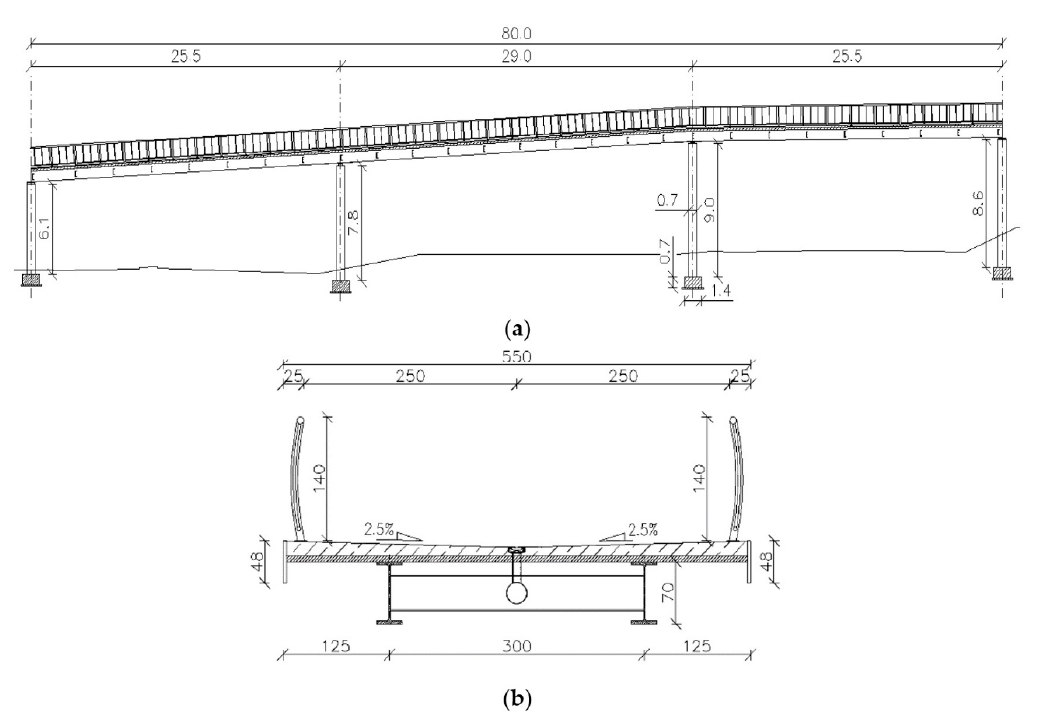
Figure 4. The general view with dimensions [m] ( a ) and the cross-section with dimensions [cm] ( b ) of the three-span continuous beam footbridge with the reinforced concrete (RC) slab.